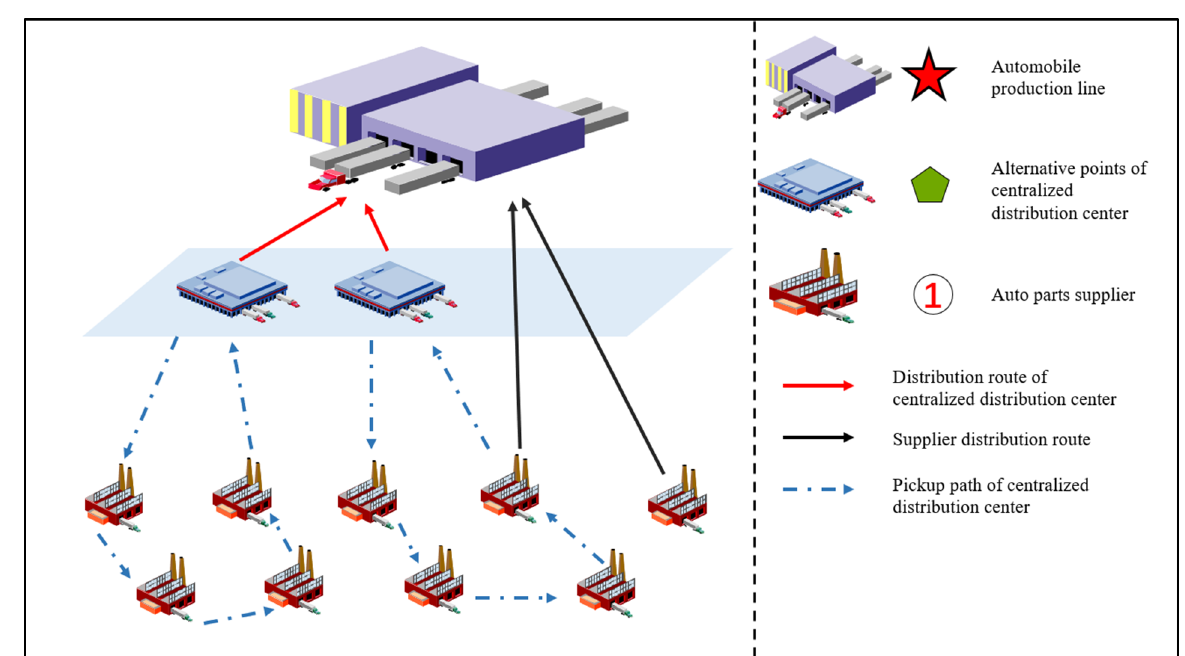
Figure 2. LIRP in the auto parts supply network.